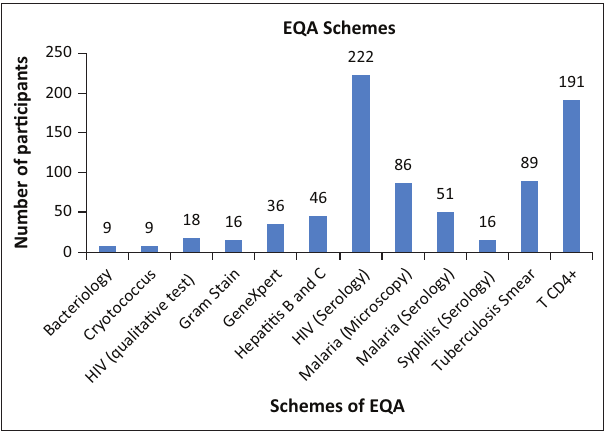
FIGURE 1: Governance structure of Mozambique’s public laboratory network.